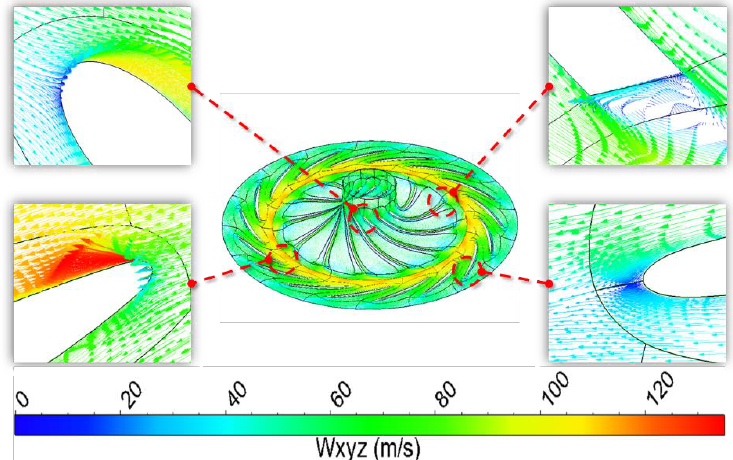
Figure 13. The velocity vector distribution of the 50% blade height section for the optimal design of the